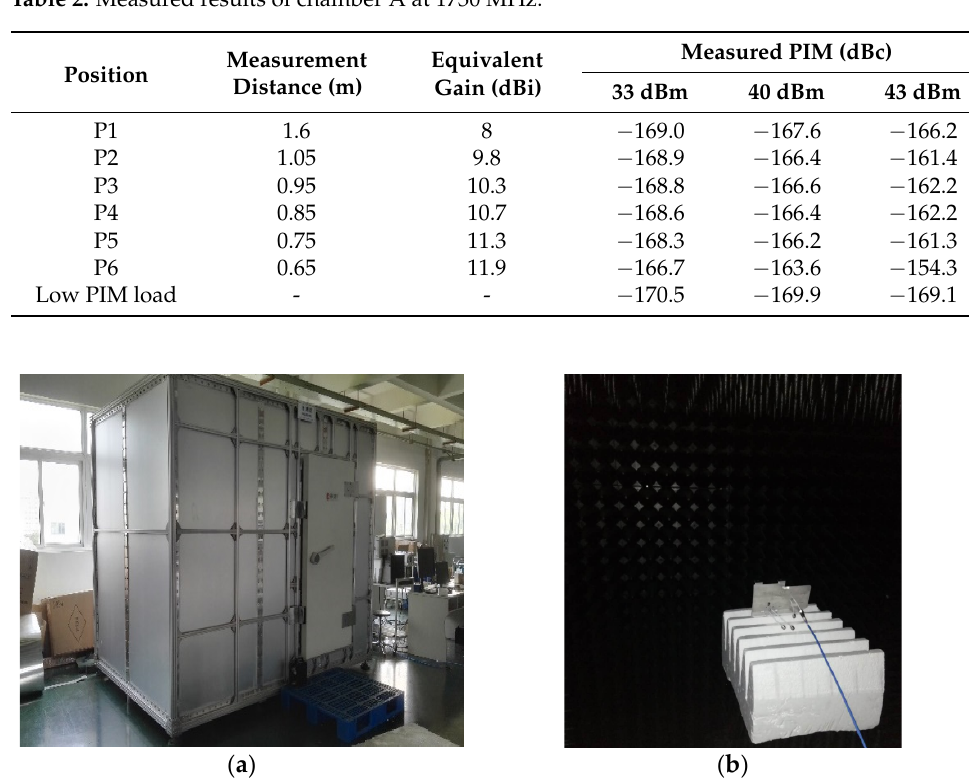
Figure 9. Measurement positions in PIM measurement chamber B. It can be seen from the two experiments that the method of measurement proposed herein can indeed obtain different PIM values at different distances. Furthermore, it can differentiate corresponding effects in chambers with different performances, which indi- cates that the method proposed here is effective. The last experiment measured a high-gain antenna, with a gain of 16 dBi, at positions P1 in the two PIM measurement chambers in order to verify the reliability of the meas- urement results. The measured power is 43 dBm, and the antenna works at approximately 900 MHz. According to the test results of the two experiments outlined above, it is evident that chamber A will yield errors when measuring the 16 dBi antenna. Although the per- formance of the 16 dBi antenna was not verified in chamber B, the results show that the measurement results will be superior to those of chamber A. The results of measurements from the third experiment are shown in Table 5. An outdoor measurement is used for